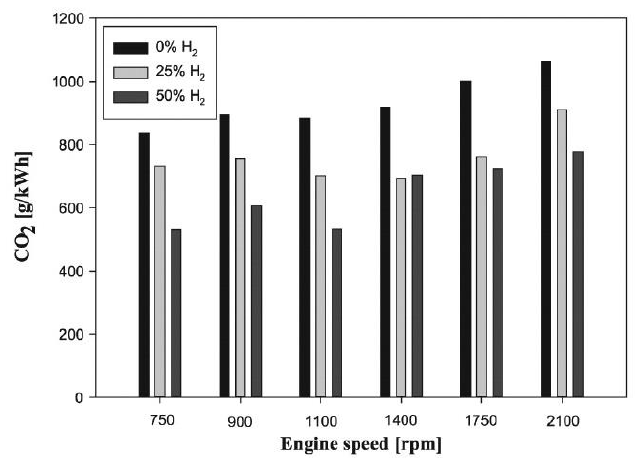
Figure 14. Reducing CO 2 emission using hydrogen fuel in diesel engines [78].